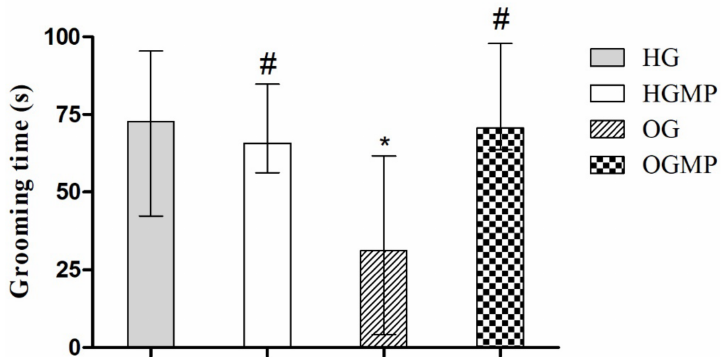
Figure 4. Results of the splash test (grooming time in seconds) in healthy and obese rats treated or not with MP seed extract. Data presented as median (minimum and maximum). Kruskal-Wallis test, Dunn post-hoc ( p ≤ 0.05). * di ff ered from HG; # di ff ered from